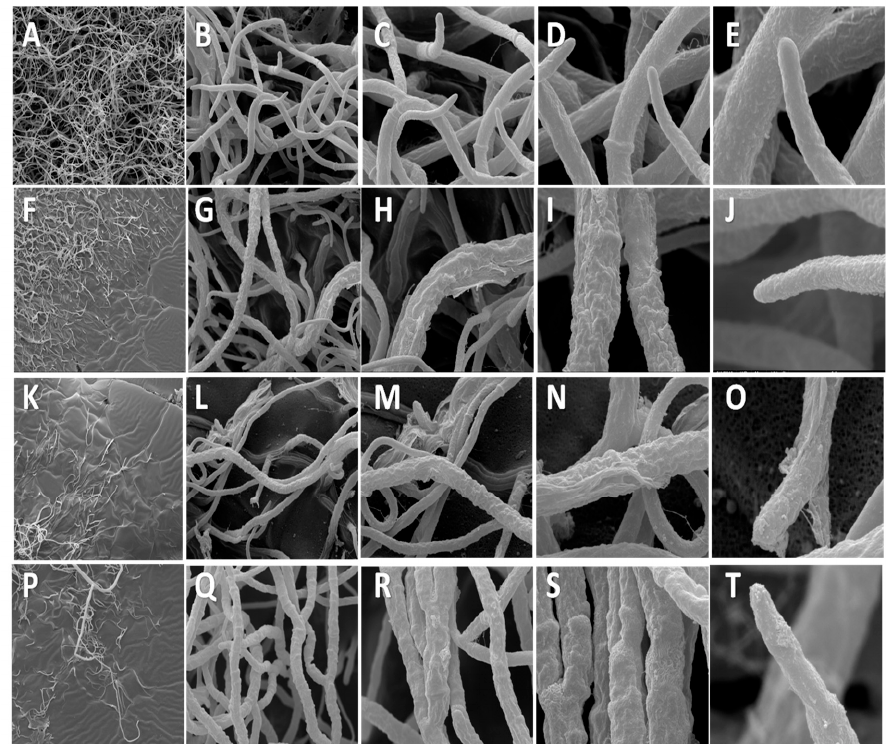
Figure 7. Scanning electron microscopy images of antifungal effect of salts against Botrytis cinerea . ( A – E ) Control after 96 h after incubation; ( F – J ) treatment with potassium bicarbonate (PB) at 0.2%; ( K – O ) treatment with sodium silicate (SSi) at 0.2%; ( P – T ) treatment with calcium chelate (CCh) at 0.2%. In the magnitude of 400 × (A-P; bar 300 µ m), 3000 × (B–Q; bar 20 µ m), 6000 × (C-R; bar 20 µ m), 12,000 × (D-S; bar 10 µ m) and 24,000 × (E-T; bar 5 µ